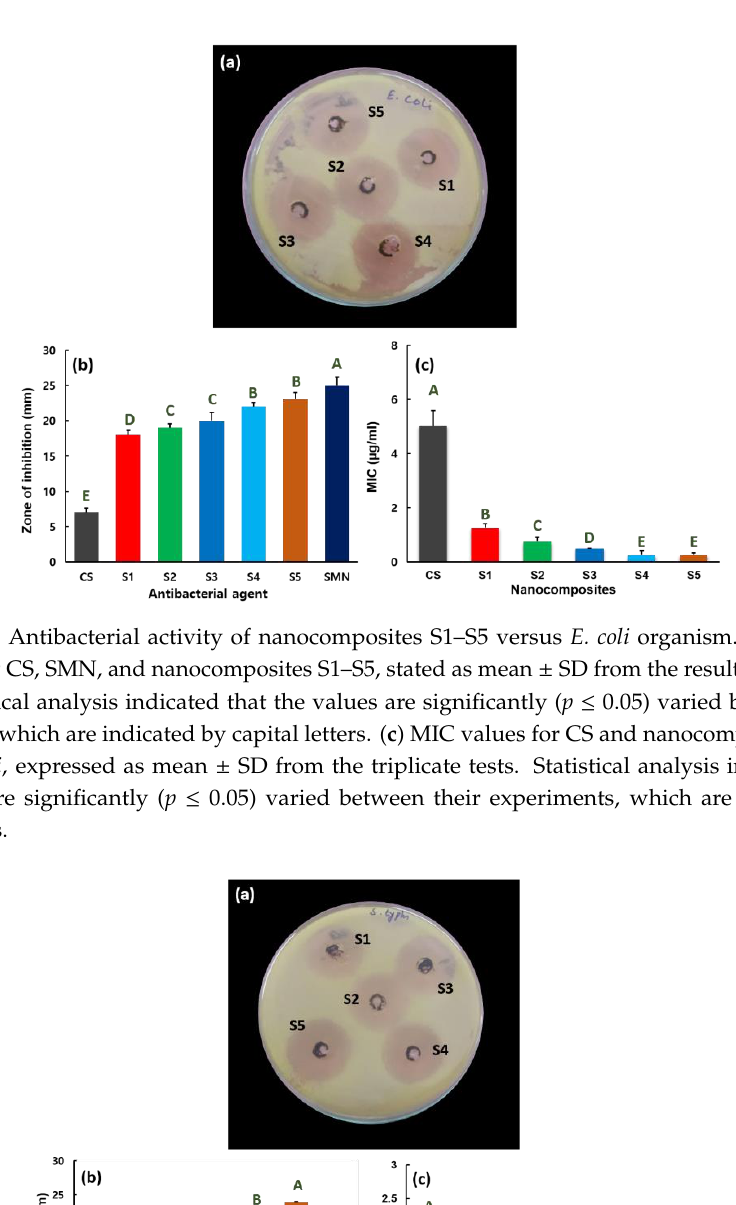
Figure 6. ( a ) Antibacterial activity of S1–S5 nanocomposites versus S. typhi organism. ( b ) Zone of inhibition for CS, SMN, and nanocomposites S1–S5, stated as mean ± SD from the results of triplicate tests. Statistical analysis indicated that the values are significantly ( p ≤ 0.05) varied between their experiments, which are indicated by capital letters. ( c ) MIC values for CS and nanocomposites S1–S5 versus S. typhi , expressed as mean ± SD from the triplicate tests. Statistical analysis indicated that the values are significantly ( p ≤ 0.05) varied between their experiments, which are indicated by capital